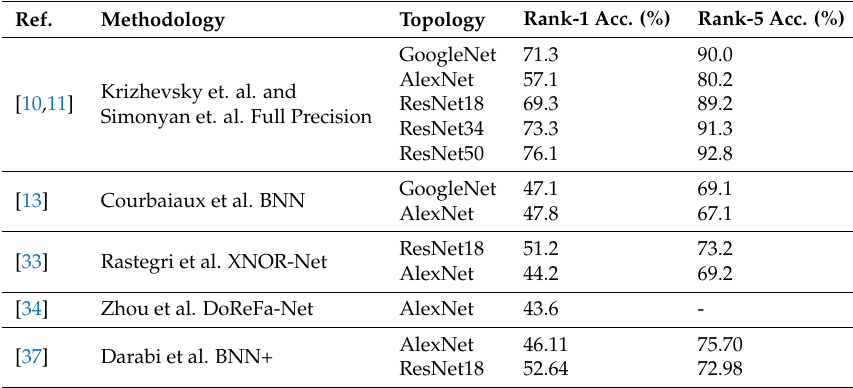
Table 2. Accuracy of different Methodology on the ImageNet